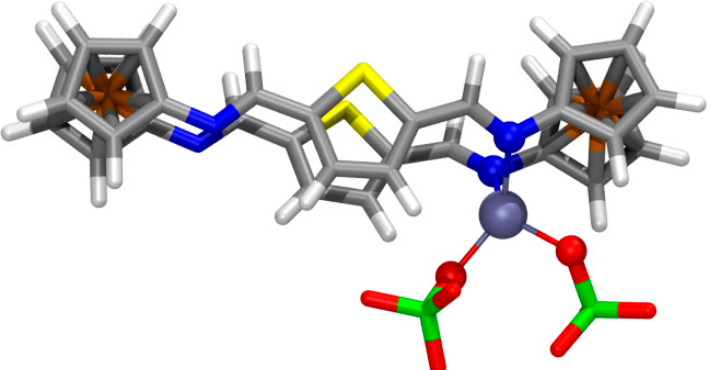
Figure 6. Computed (B3LYP-D3/def2-TZVP) most stable geometry for complex 4 ·Zn(ClO Capped sticks representation except for the central metal cation and directly linked donor atoms that are highlighted in ball